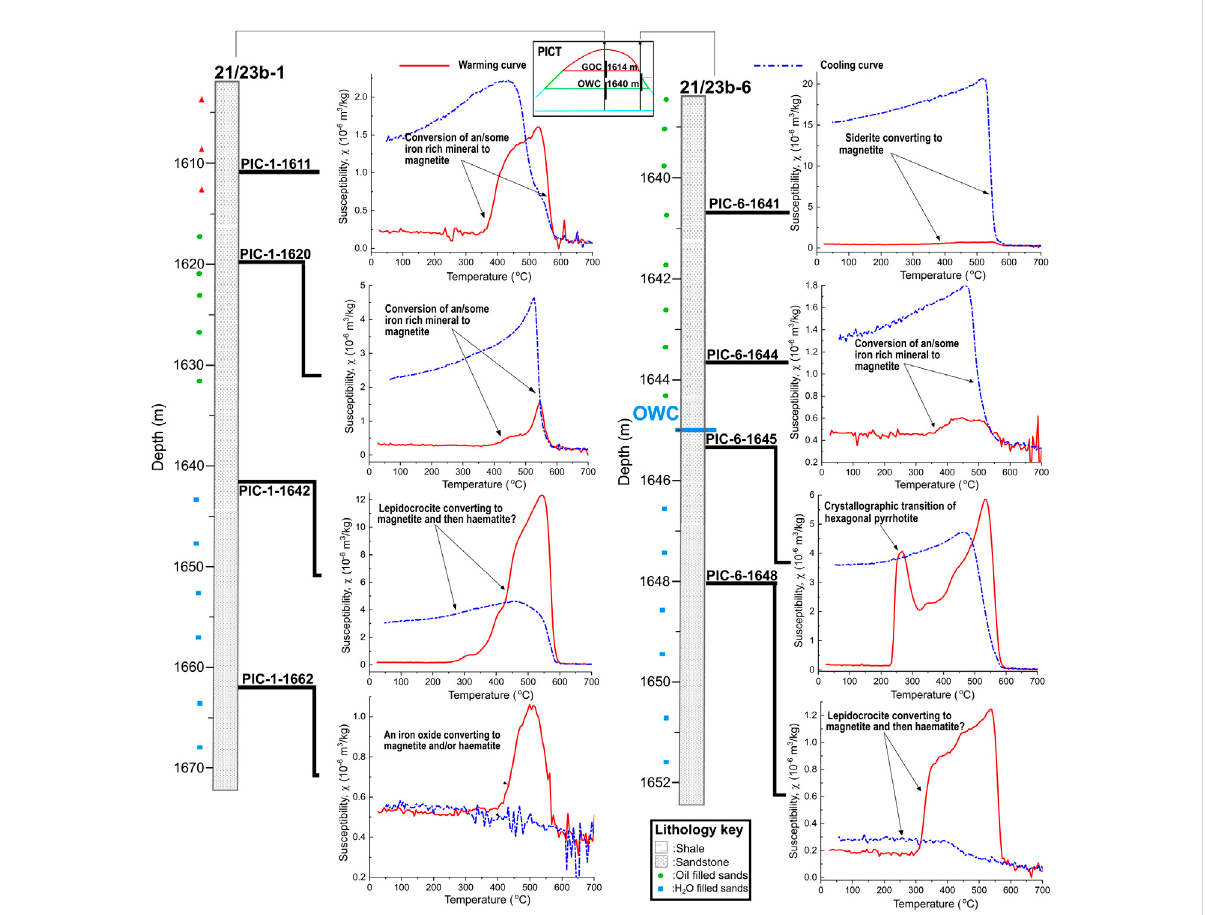
FIGURE 4 Example results from the HT- χ measurements carried out on the Pict samples. The reservoir sands of the main hydrocarbon leg contain signi fi cantly less siderite than the same region in the Bittern fi eld although isolated peaks have been identi fi ed in the crestal samples. The oil-water contact region presents adistinct signature with theidenti fi cationof hexagonal pyrrhotite and lepidocrocite. Compared to theoilwater contact, the water leg presents a signi fi cantly diminished lepidocrocite signature. Note that the OWC marked is as estimated from well logs and core analysis. This suggests a slightly tilted